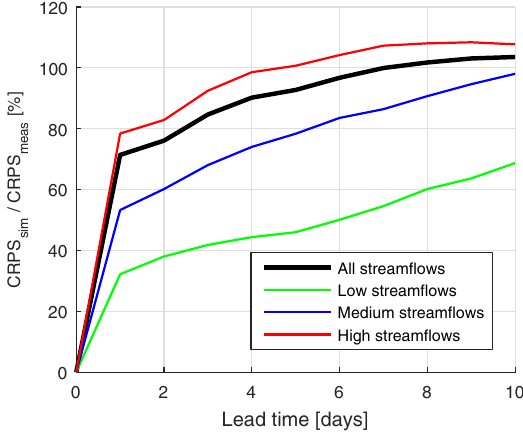
Figure 8. Ratio of errors in meteorological forecasts (CRPS sim ) to meteorological forecast + model errors (CRPS meas